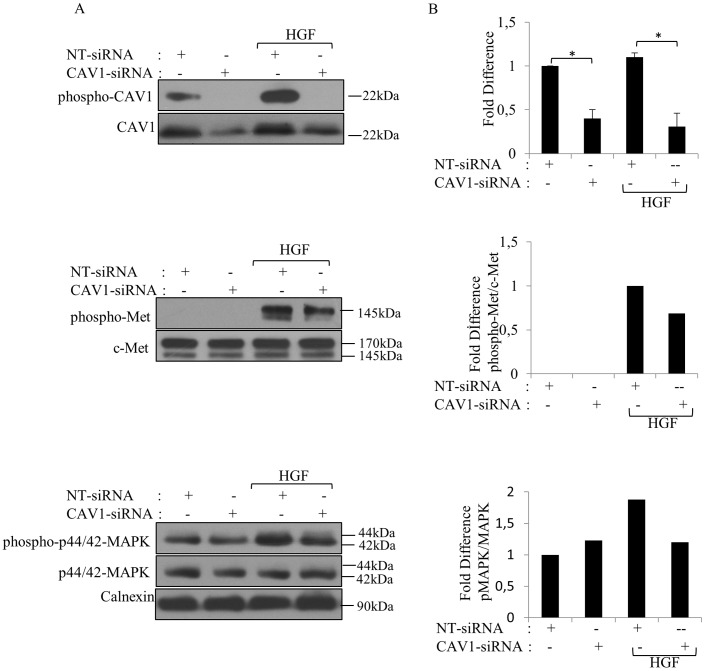
CAV1 knockdown inhibited HGF evoked activation of c-Met signaling pathway.
A. SNU-449 cells transfected with CAV1-siRNA or NT-siRNA for 72 h, stimulated with HGF for 30 min were subjected to WB analysis with indicated antibodies. Calnexin was used as a loading control. B. The graph depicting results from densitometry quantitation of CAV1 band which was normalized to calnexin. Error bars represent S.E. (n = 5). Band intensities of phospho-Met and p-MAPK were quantified by densitometry and normalized to c-Met and MAPK, respectively (n = 3). Values from NT-siRNA were set at 1. ANOVA was used in comparison of groups. (*p<0,05, NS: not significant).